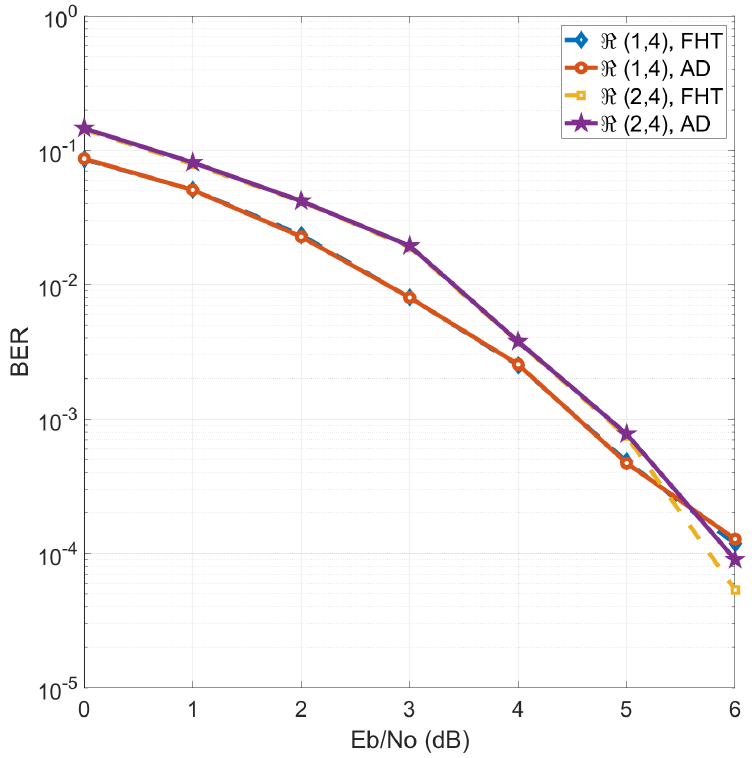
Figure 5. BER of RM decoding with FHT and